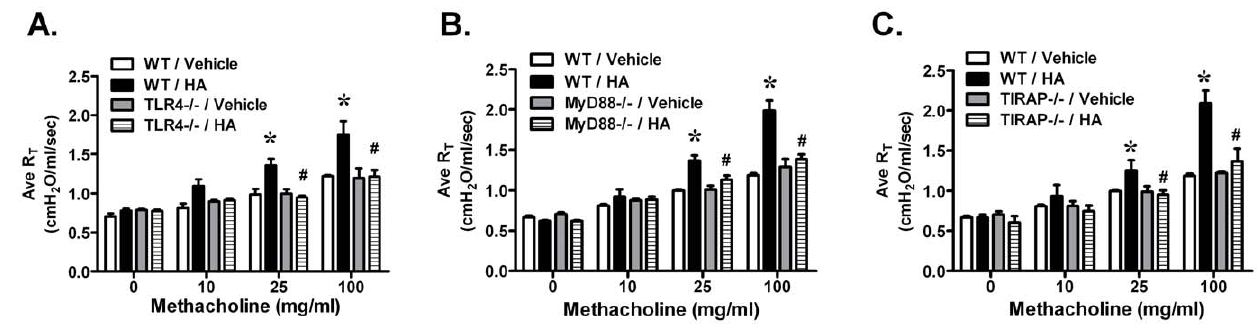
Figure 6. Airway reactivity to HA challenge was dependant on TLR4, MyD88, and TIRAP. HA increased AHR in WT mice, but not in ( A ) TLR4 2 / 2 mice, ( B ) MyD88 2 / 2 mice, or ( C ) TIRAP 2 / 2 mice (*p , 0.05 vs. vehicle-WT; # p , 0.05 vs. HA-WT, N=5 per group).